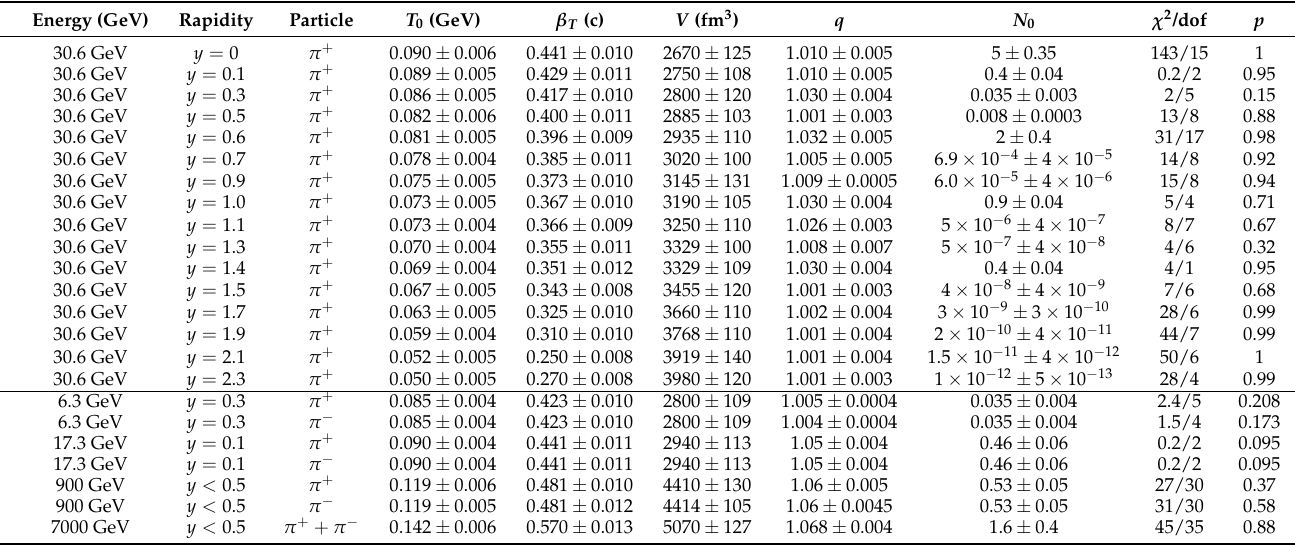
Table 2. ( n 0 = 2) Values of free parameters T 0 and β T , V and q, normalization constant ( N 0 ), χ 2 and degree of freedom (dof) corresponding to the curves in Figure 1. The p -values of the χ 2 -statistics are also presented, which were calculated in R-software by pchisq ( χ 2 values, degree of